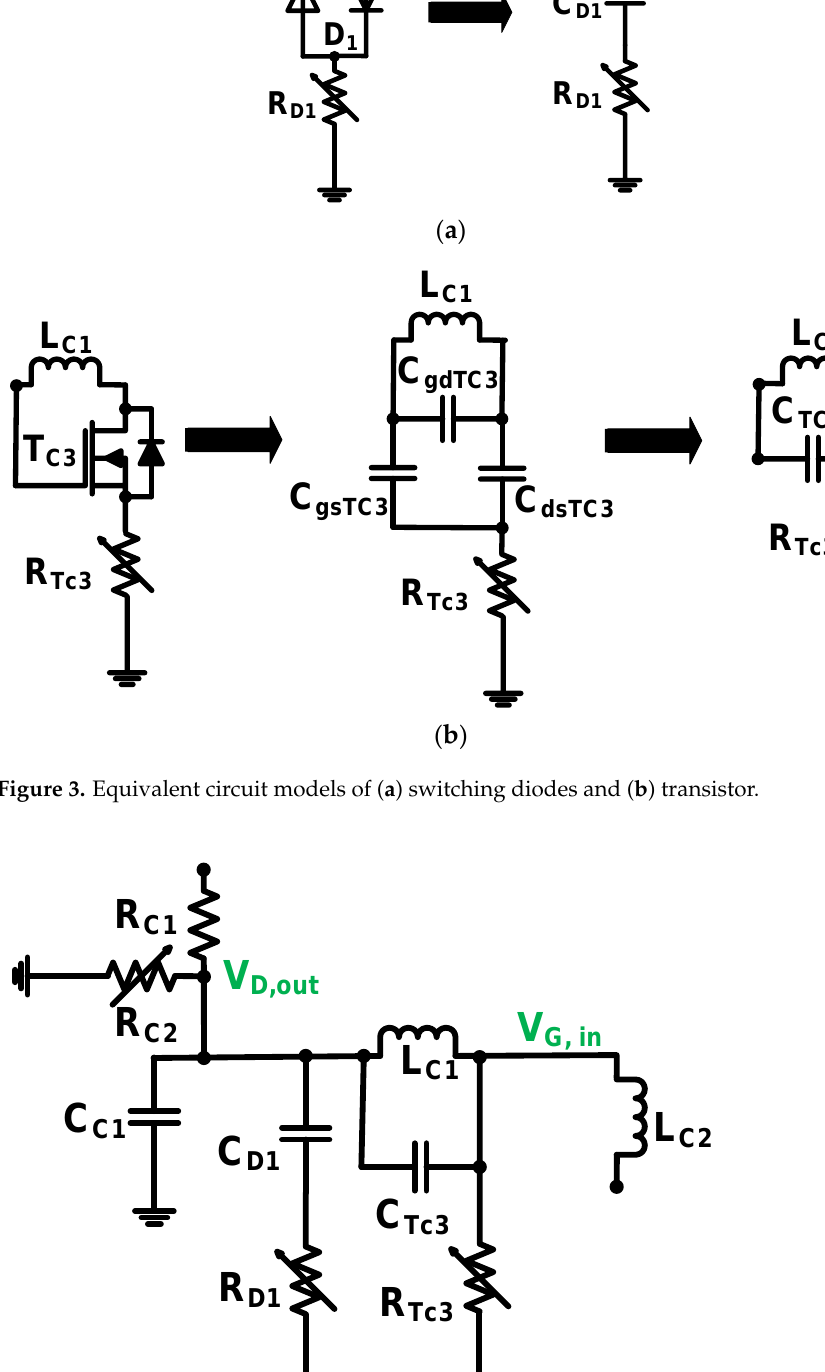
Figure 4. Equivalent circuit models of voltage divider with high-voltage transistor and switching diodes.